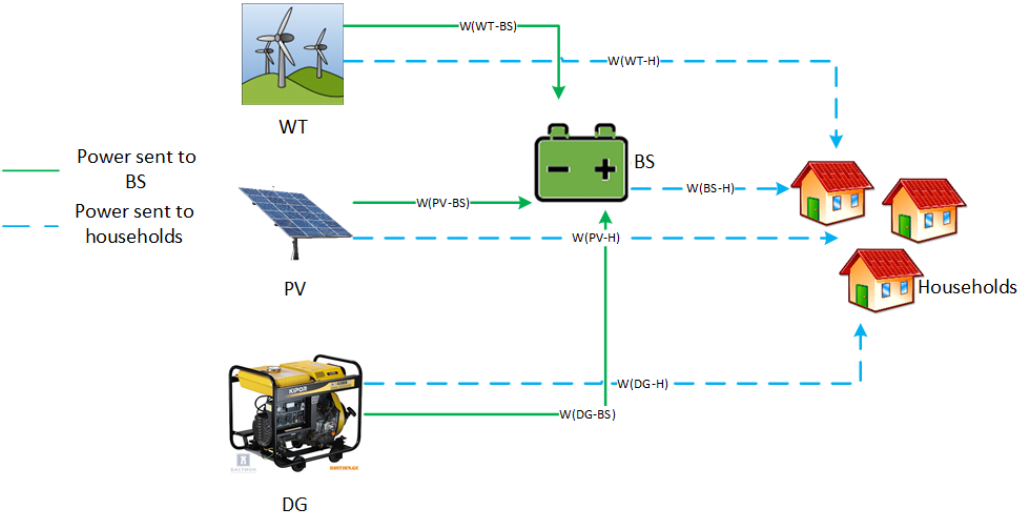
Figure 2. Superstructure to supply electricity to the rural